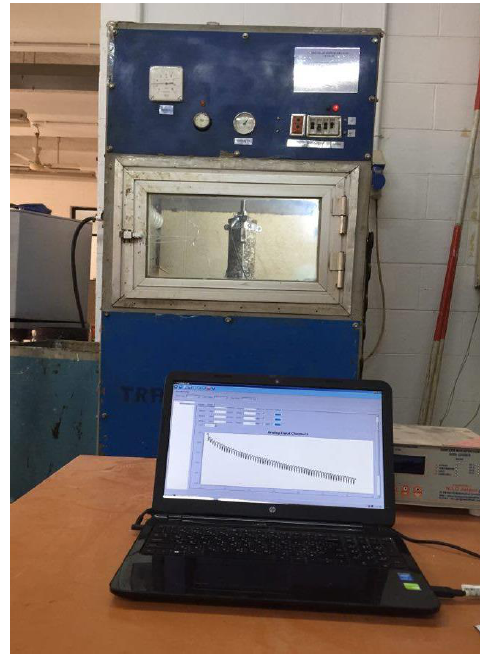
Figure 6. The uniaxial repeated loading test.